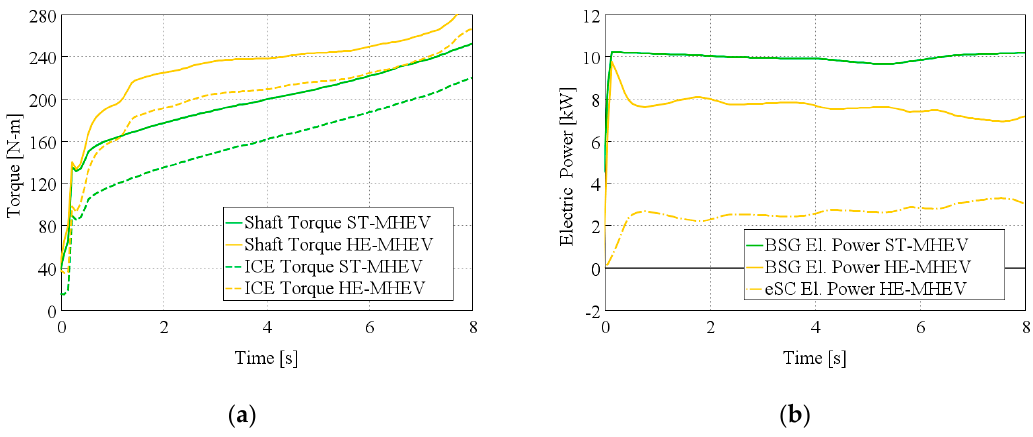
Figure 9. Details of the 60-80 km/h in VI gear maneuver: ( a ) shaft torque in solid lines, ICE torque in dashed lines; ( b ) BSG electric power in solid line, eSC electric power in dashed line.